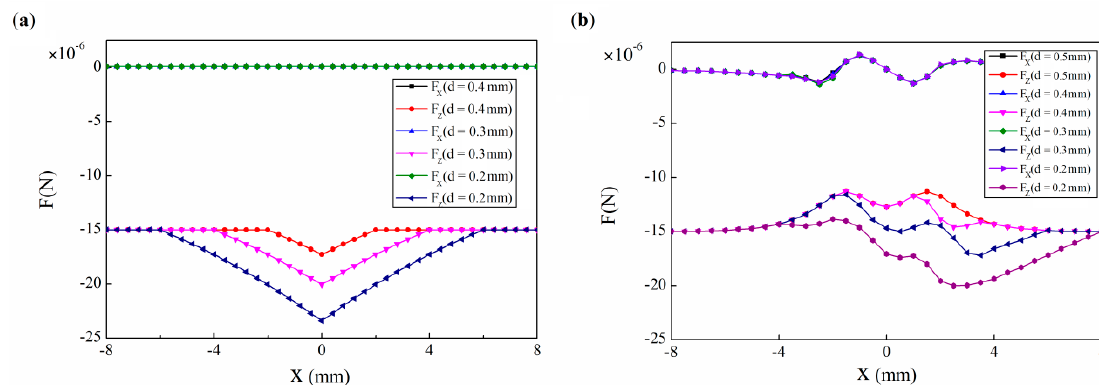
9 of 11 Figure 8. The voltage signal strength integral value in the z -direction as indicated in Figure 7a, varies approximately linearly with the different defect volumes. 4.3. Distinguish and Precisely Evaluate Lift-off Effect Lift-off effect is one of the major problems of the ECT method and is caused by the electromagnetic field weakening or strengthening due to variation of the lift-off distance. Signals caused by such lift-off are usually difficult to distinguish from those caused by those defects. However, as discussed, the Lorentz force in the horizontal direction has a specific feature different than that in the vertical direction, this feature has different sensitivity to defects and lift-off factors such as the varied coating thicknesses, an irregular sample surfaces or an operator movement. This feature can be utilized to reflect the extent of the lift-off. The simulation results of the measured force in the z and x -direction are shown when a sample without and with a defect undergoes a “lift-off” as shown in Figure 9. Figure 9a, we see that in the z -direction a lift-off forms a signal which could be difficult to distinguish from signals refer to defect in practice. Nevertheless, in the x -direction no signal is detected, indicating that the x-component is resistant to lift-off. When a lift-off occurs with a defect (Figure 9b), the z-component is disturbed by the lift-off, note that in Figure 5a the experimental curve has a similar shape as the z F simulation result in Figure 9b. However, the signal of the x-component is still mostly unaffected